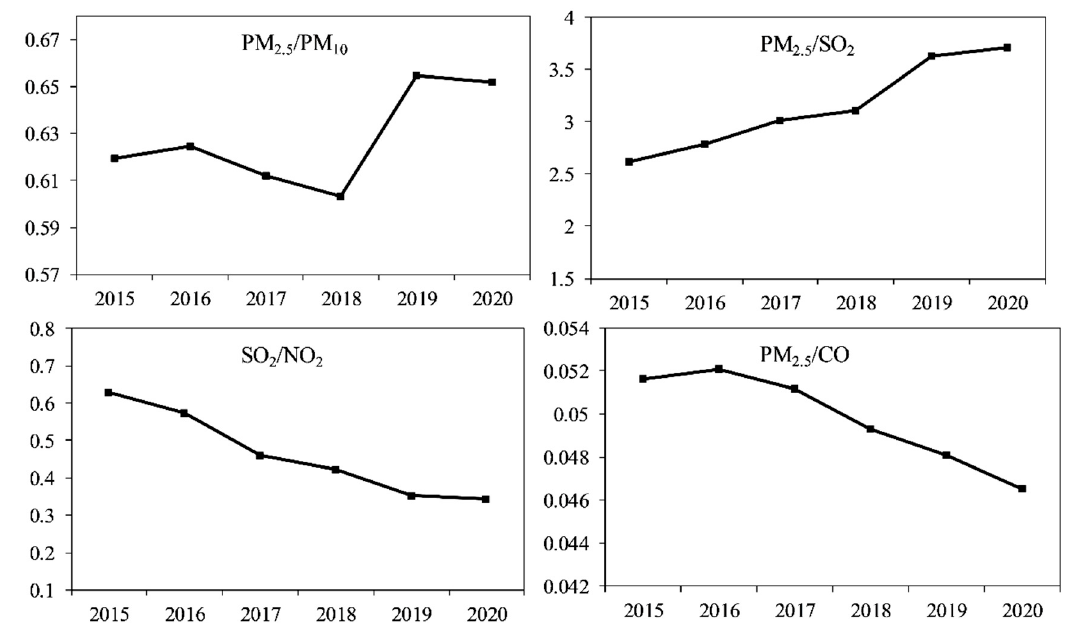
Figure A2. Annual change in the proportion of pollutants.